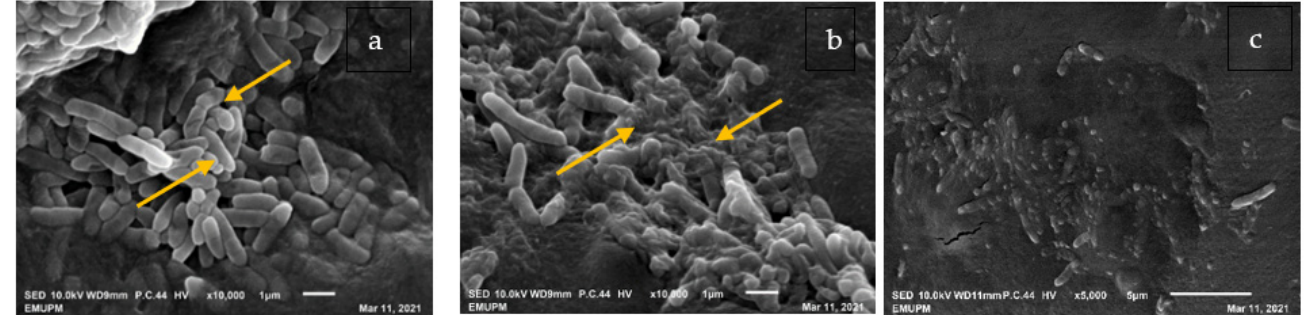
Figure 4. Scanning electron microscope images for the mechanism of action of GEO against Bg. ( a ) Regular rod shape for the DMSO-treated negative control of Bg culture after 24 h of incubation, Arrows show the smooth and regular cell shape ( b ) Irregular shape of Bg cells treated with GEO at MIC concentration, Arrows show the shriveled appearance the cell surface ( c ) Irregular growth of Bg cells treated with streptomycin (positive control) (10,000×).